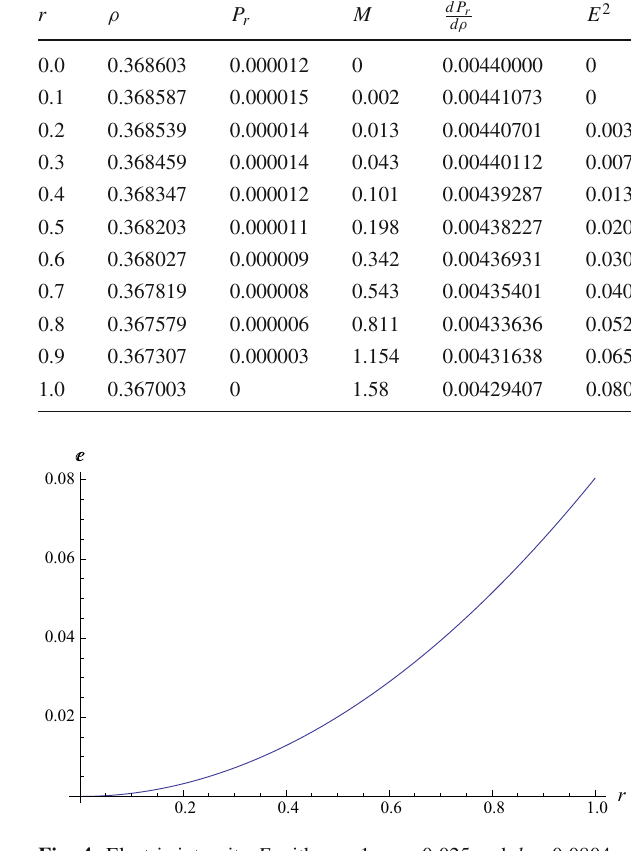
Fig. 4 Electric intensity E with n = 1 ,α = 0 . 025 and d = 0 .